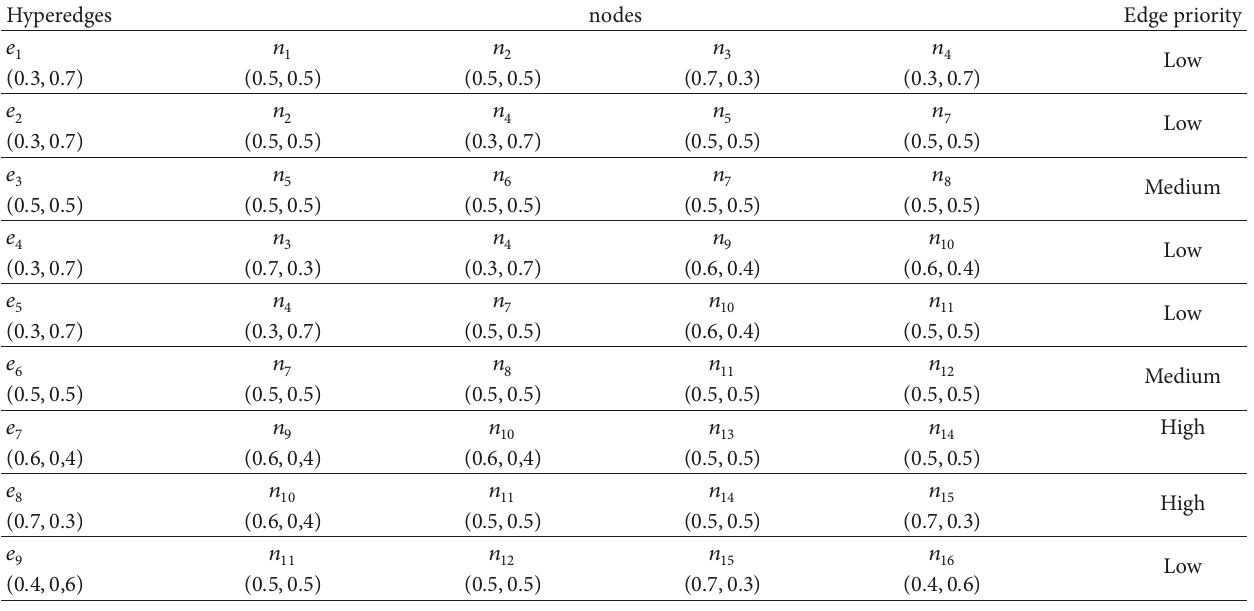
Table 1: Details of hypergraph 𝐻 𝐼𝐹 .